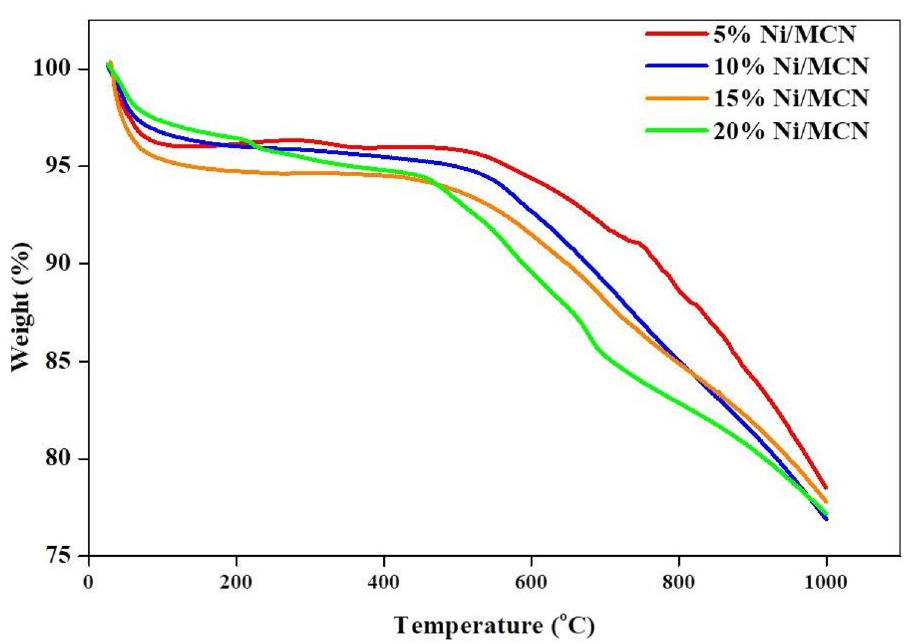
Figure 6. Thermogravimetric (TGA) analysis of the prepared